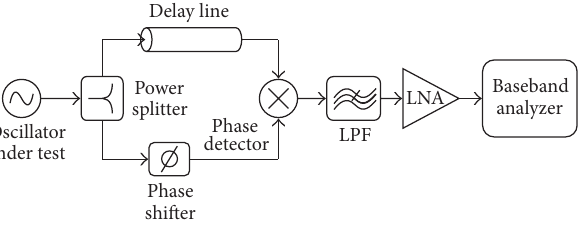
Figure 2: Delay line frequency discriminator